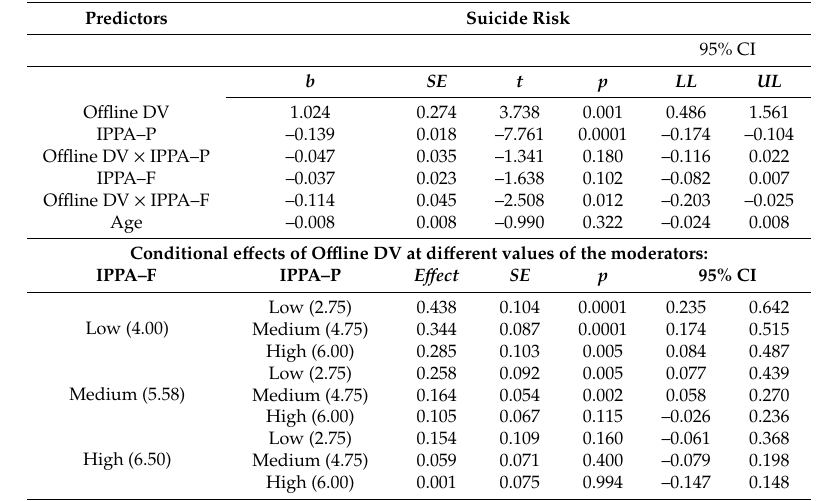
Table 4. Moderation Analyses: Conditional e ff ects of O ffl ine on Suicide Risk at Di ff erent Values of the IPPA–P and IPPA–F.